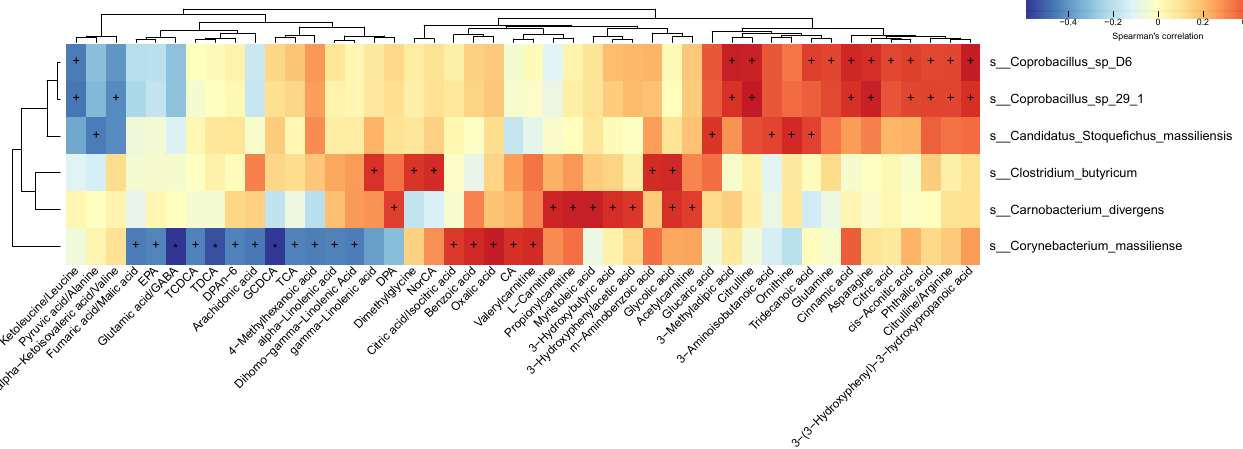
Figure 4. Correlation analysis of the differential species and all detected plasma metabolites. The correlation analyses between the differential species within the intervention period and all the detected plasma metabolites were conducted by the Spearman correlation coefficient. Color depth indicates the strength of correlation, with red representing positive correlation and blue for the negative correlation. An asterisk ‘+’ indicates p < 0.05, and an asterisk ‘*’ stands for p <